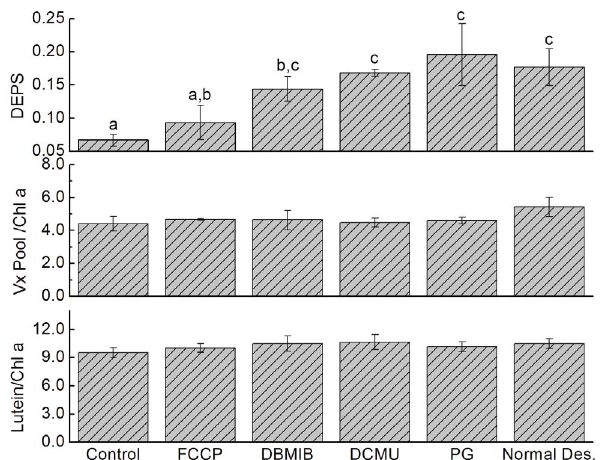
Figure 6. Effects of an uncoupler and various metabolic inhibitors on the Xc and lutein content of U. pertusa thalli during desiccation in air under dim light. Chemicals were infiltrated into thalli before desiccation treatment. The de-epoxidation state (DEPS) and the contents of the Vx pool and lutein were measured after severe water loss ( , 20% water content), except in the control, which was fully hydrated. Normal Des. represents desiccation of thalli without any inhibitor treatment. Experimental conditions were as in Fig. 2. Error bars represent SD for n=3.